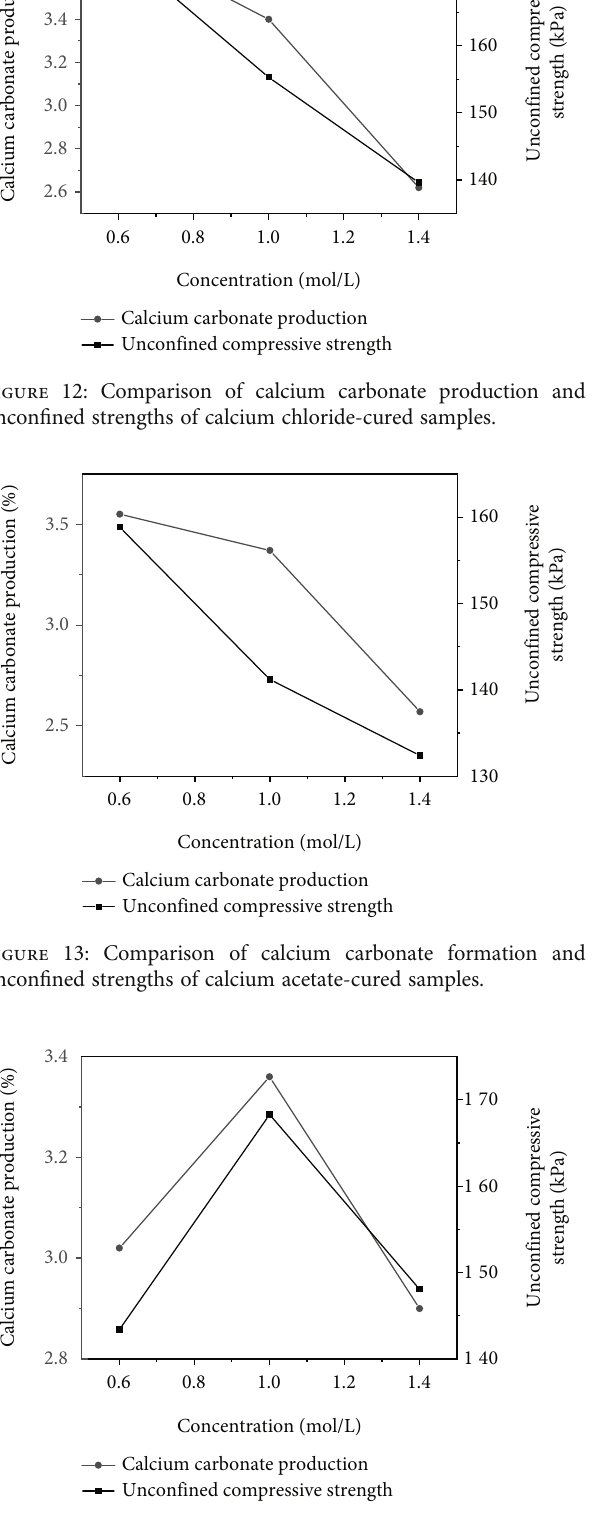
Figure 14: Comparison of calcium carbonate production and uncon fi ned strengths of calcium gluconate-solidi fi ed